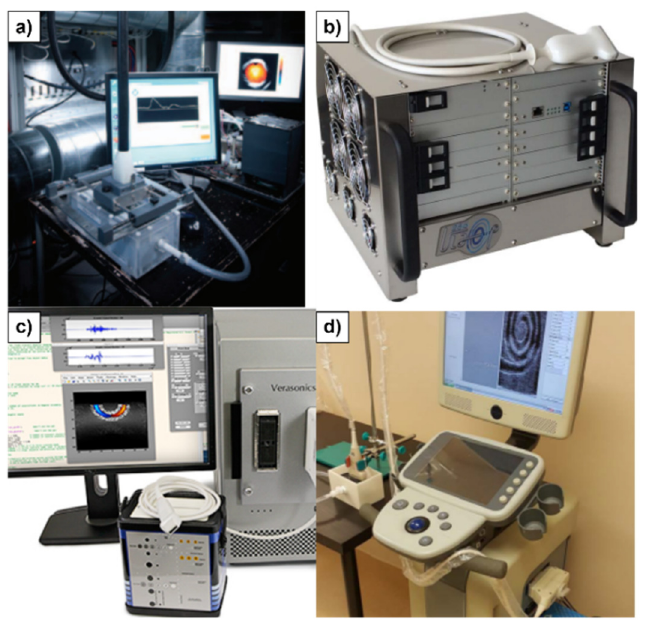
Figure 1. Adapted photographs of Open Architecture Ultrasound Systems: ( a ) SARUS [16], ( b ) ULA-OP [21], ( c ) Verasonics, and ( d ) SonixTouch [21].